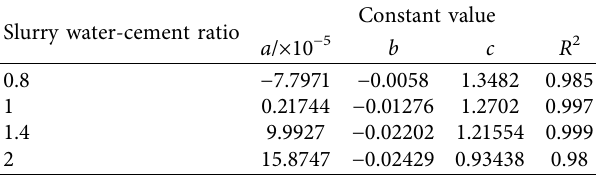
Table 2: Constant values of degradation ratio. Slurry water-cement